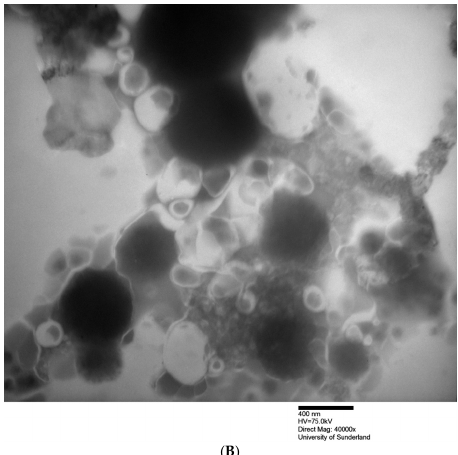
Figure 1. Transmission electron microscopy (TEM) images of formulations E1 (top, A ) and E2 (below, B ) before sonication.